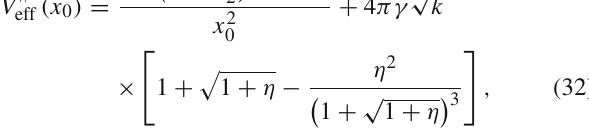
of k and η , the coefficient of γ behaves quadratically with respect to the reduced equilibrium radius x 0 , indicating that the universal shape of β 2 against for a general form of γ ∝ x n 0 x 0 is predictable. For the sake of comparison, the associated functions for β 2 are brought in the following for three arbitrary choices of γ at equilibrium. Herein, coefficients are chosen such that